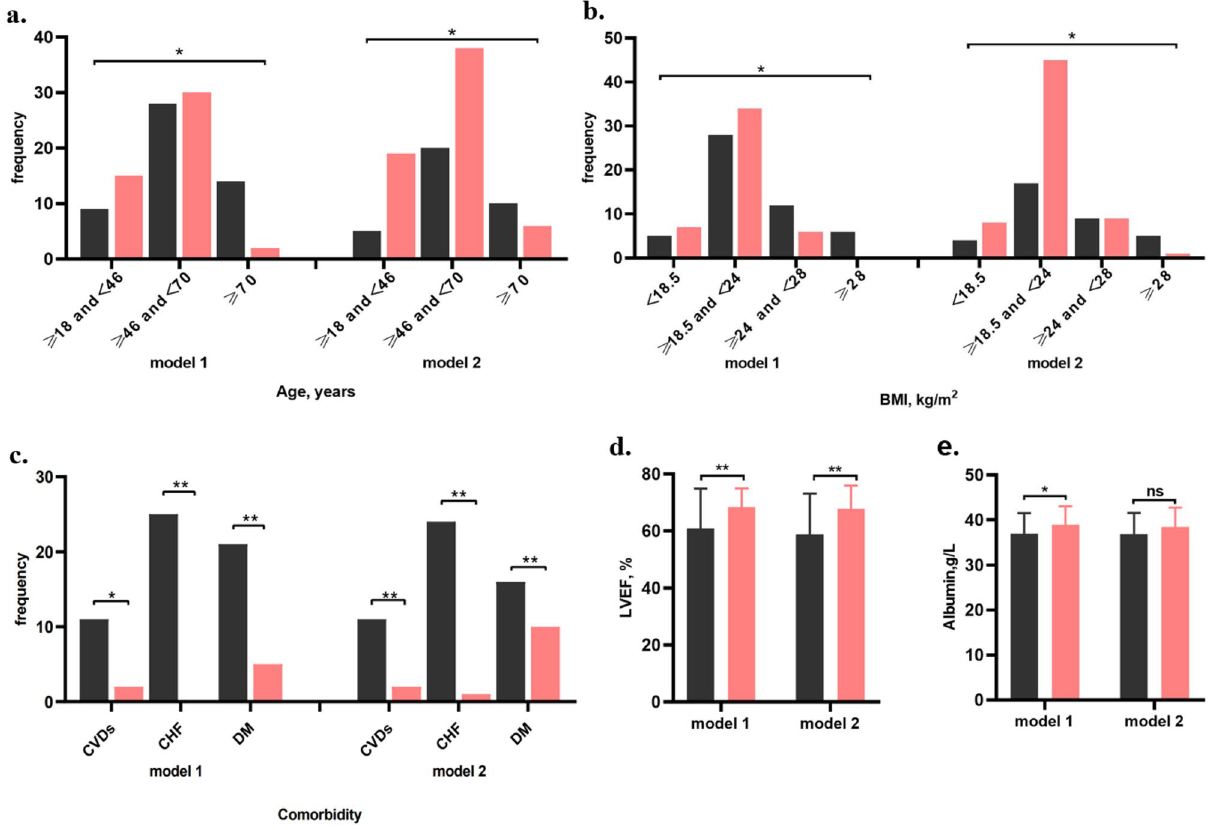
Figure 2. The differences of age ( a ), BMI ( b ), comorbidity ( c ), LVEF ( d ), serum levels of albumin ( e ) between event group and non-event group. BMI: body mass index; CVDs: cardiovascular diseases; CHF: chronic heart failure; DM: diabetes mellitus; LVEF: left ventricular ejection fraction; black column: event group; red column: non-event group; model 1: overall clinical events as the endpoints; model 2: LSCEs as the endpoints; ns: no significance; * p < 0.05; ** p <